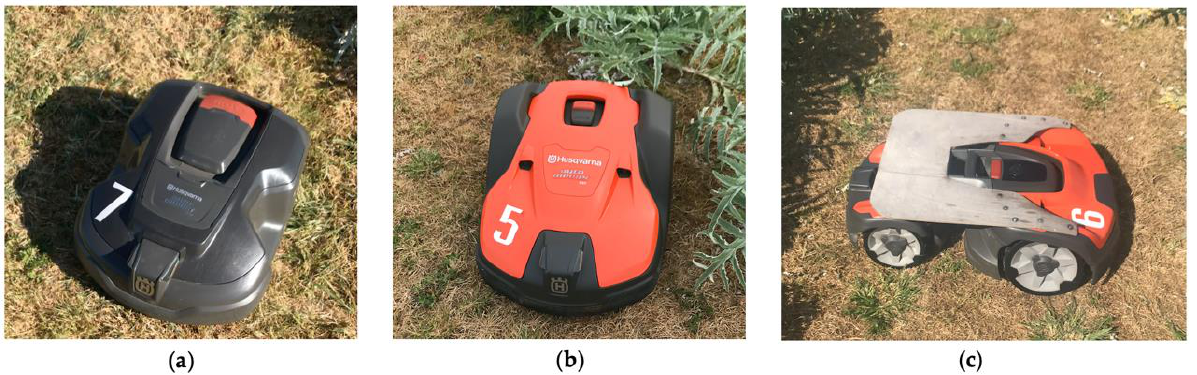
Figure 2. The three autonomous mowers compared during the first trial: ( a ) AM1, ( b ) AM2 and ( c ) AM3.